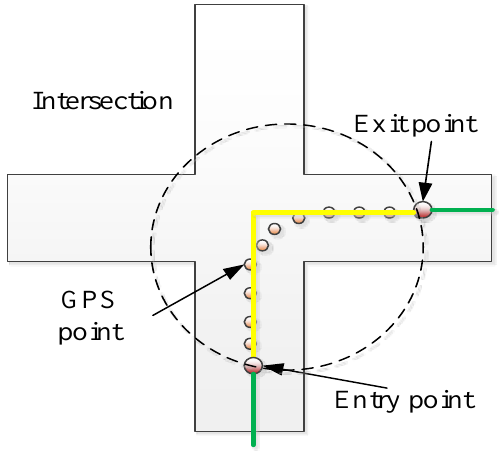
Figure 3. Map-building in special path.